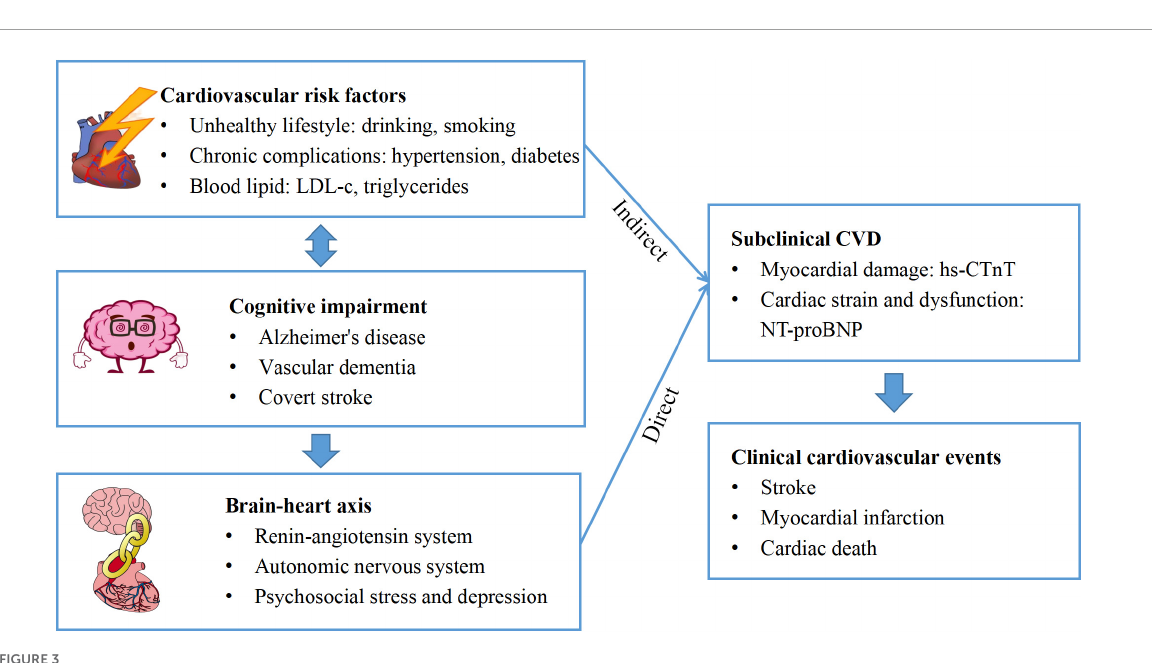
An association between cognitive impairment and incidence of elevated hs-CTnT and NT-proBNP would be expected for several reasons. According to our results, individuals with